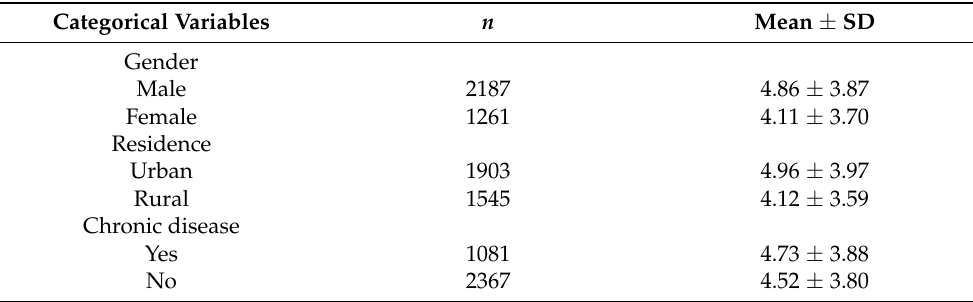
Table 7. Descriptive statistics of logical sequence test scores of categorical variables.